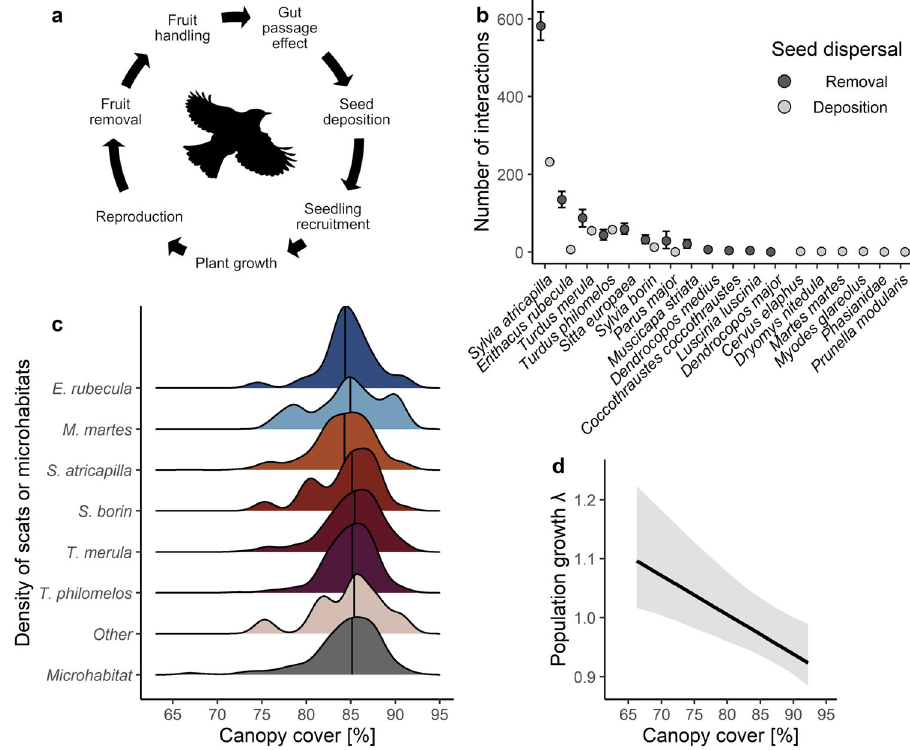
Fig. 1 The seed dispersal loop 34 of animal-dispersed plants. a Animal seed dispersal as a demographic bridge between reproductive adults and new plant recruits. b Fruit removal: the number of visits of animal species to the fl eshy-fruited tree Frangula alnus ( ‘ Removal ’ 51 ) and the number of scats with seeds of F. alnus ( ‘ Deposition ’ 53 ) in the Bia ł owie ż a Forest, Eastern Poland. Two more disperser species were only observed using camera traps (Supplementary Table 3). Means ± 95% prediction interval based on 500 bootstraps of dispersal data. c Seed deposition: the effect of different animal species on relative scat deposition density along the canopy cover gradient. The relative availability of microhabitats is shown for comparison. A vertical line indicates the median of a distribution. d Plant performance: relationship between the population growth rate of F. alnus and canopy cover when seeds are solely dispersed by gravity. The 95% prediction interval is based on 500 bootstraps of plant data. The bird silhouette (public domain) was obtained from